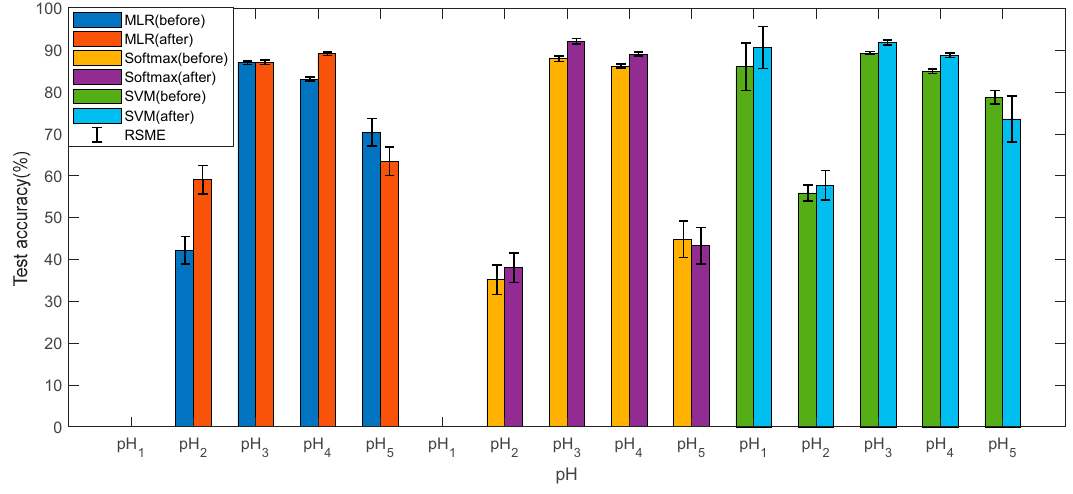
Figure 8. The test accuracy for each pH by three methods.